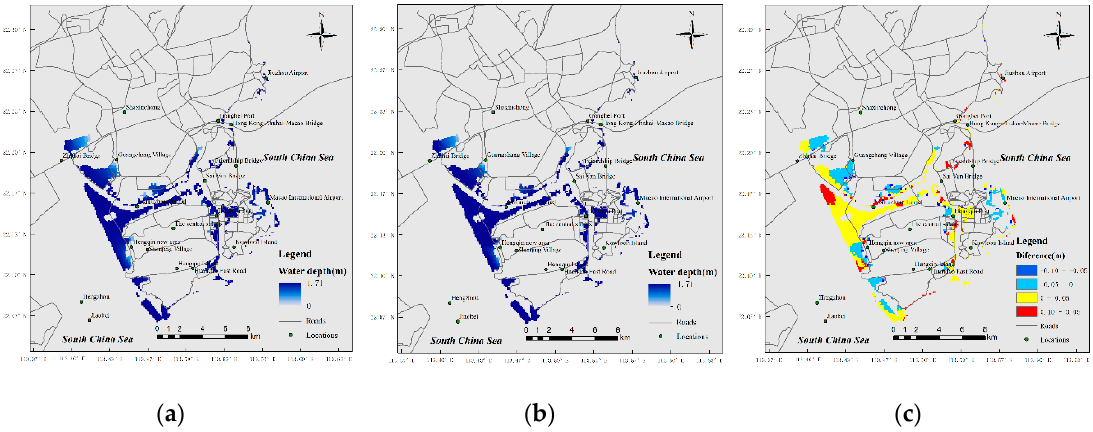
Figure 7. Inundation estimated by ( a ) MIKE 21 and ( b ) the CA simulated inundation, and ( c ) their difference (MIKE 21-CA) at 120 min.